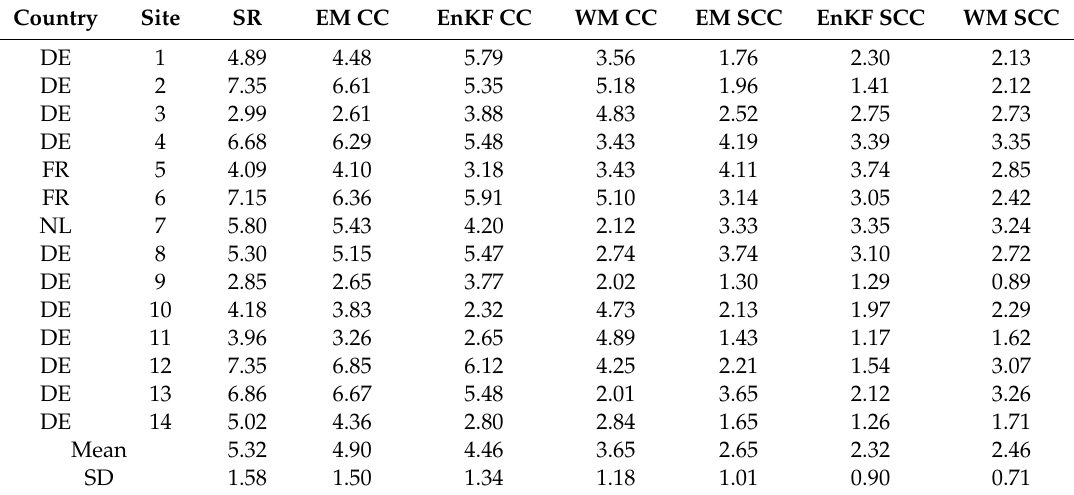
Table 3. RMSE results for total aboveground biomass. SR: Standard Run, EnKF: Ensemble Kalman Filter, WM: Weighted Mean, EM: Ensemble Mean, CC: Crop Component Set, SCC: Soil and